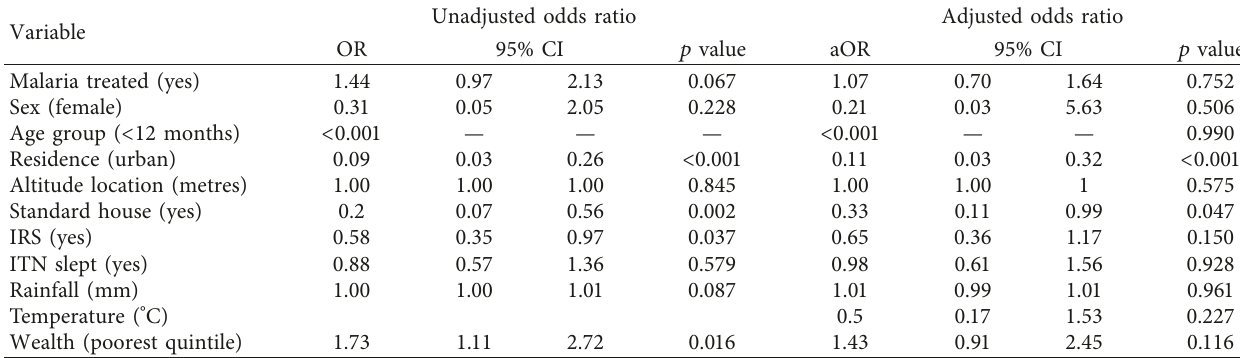
Table 3: Effect size measures of variables on prevalence using data from the whole